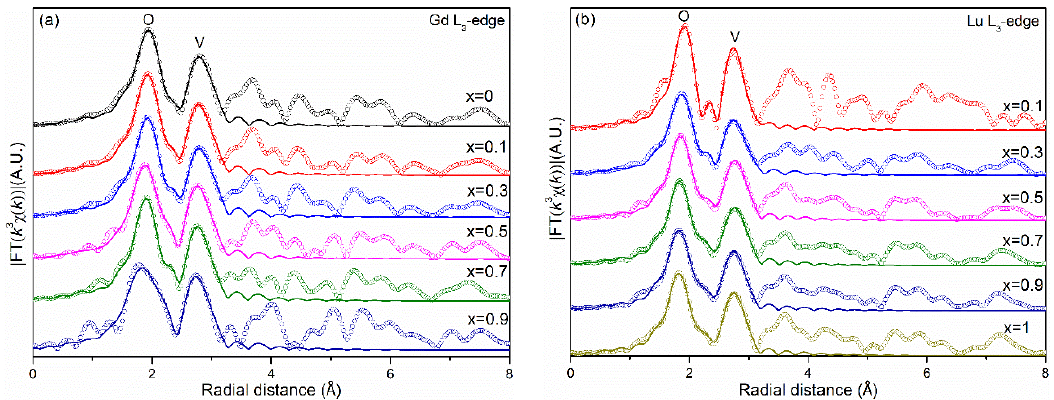
Figure 5. Magnitude of the Fourier-transformed EXAFS spectra (hollow circles) and the correspond- ing fitting curves (solid lines) of the first two coordination shells at the ( a ) Gd L 3 -edge and ( b ) Lu L 3 -edge for Lu x Gd 1 − x VO 4 solid solutions.